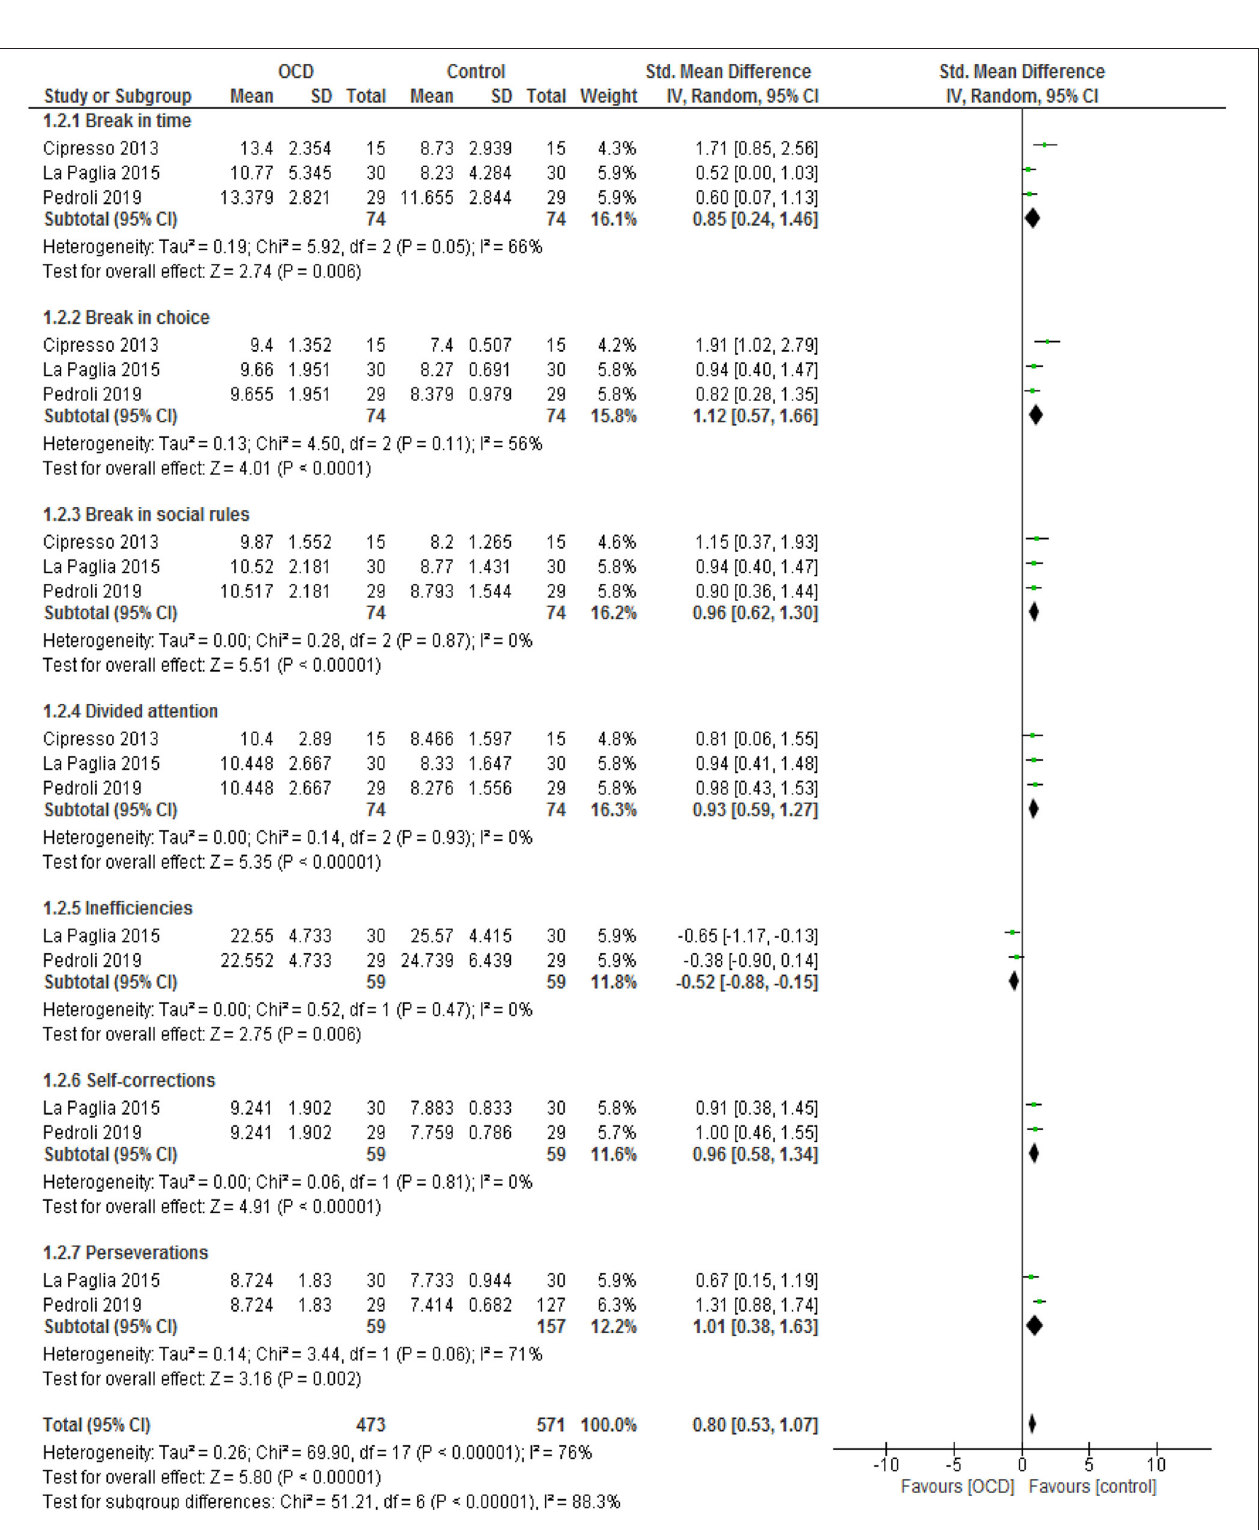
FIGURE 2 | Forest plot for VR scoring. The green blocks indicate the weight assigned to the study, the horizontal line depicts the CI, and the black rhombus shows the overall result. IV, inverse variance; Std, standard.